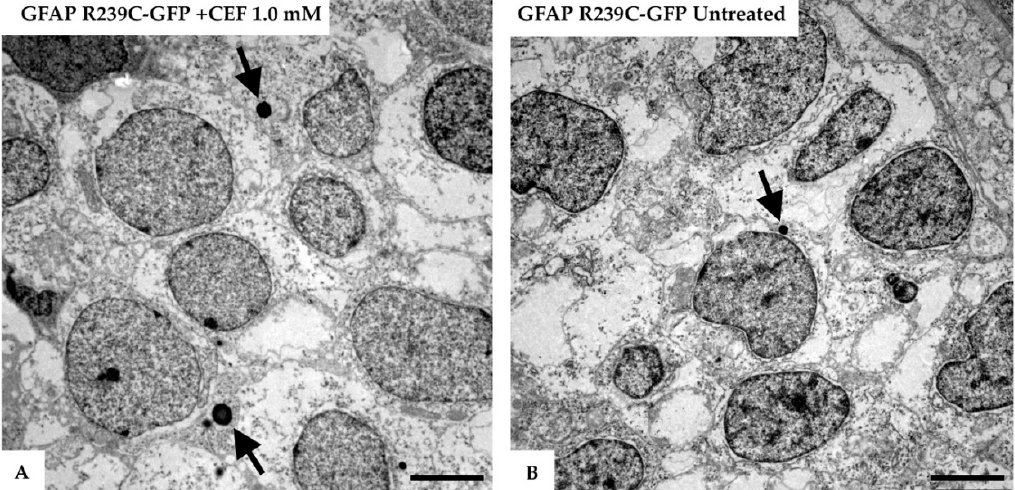
Figure 12. Electron micrographs of the telencephalon of 3 dpf zebrafish embryos expressing GFAP R239C-GFP.( A ) The formation of lysosomes (arrows) was confirmed in the electron micrographs of the telencephalic region from a 3 dpf old zebrafish, injected with GFAP R239C-GFP plasmid and treated with 1.0 mM ceftriaxone for 48 h. ( B ) In contrast, in mutant untreated embryos, fewer and smaller lysosomes were seen at this embryonic stage. Images were captured with Zeiss EM10 or a LEO 912AB transmission electron microscope. Scale bar: 2.5 μ m.